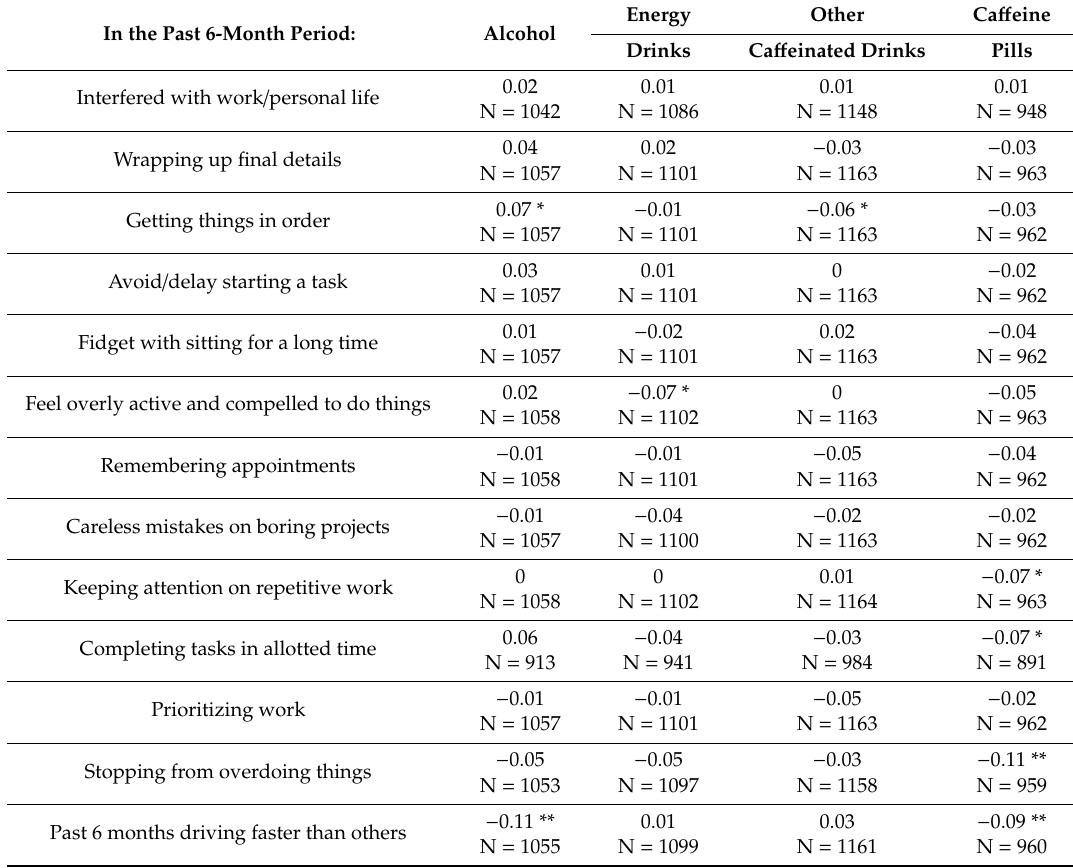
Table 4. Spearman correlation coe ffi cients between ADHD ca ff eine-users and ADHD